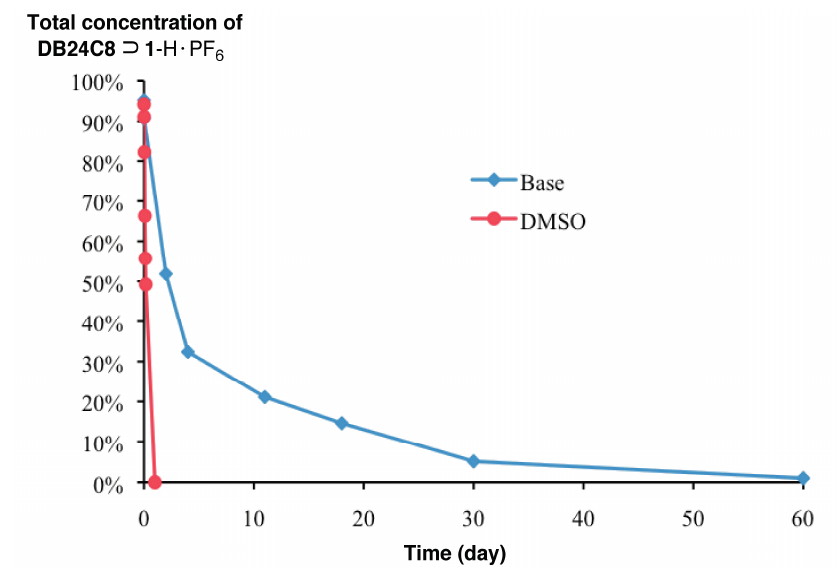
Figure 6. Dissociation data of the [2]pseudorotaxane DB24C8 ⊃ 1 -H·PF 6 in the presence of base and DMSO, characterized by 1 H NMR spectroscopy. A plot of the concentration (%) of the [2]pseudorotaxane DB24C8 ⊃ 1 -H·PF 6 versus time